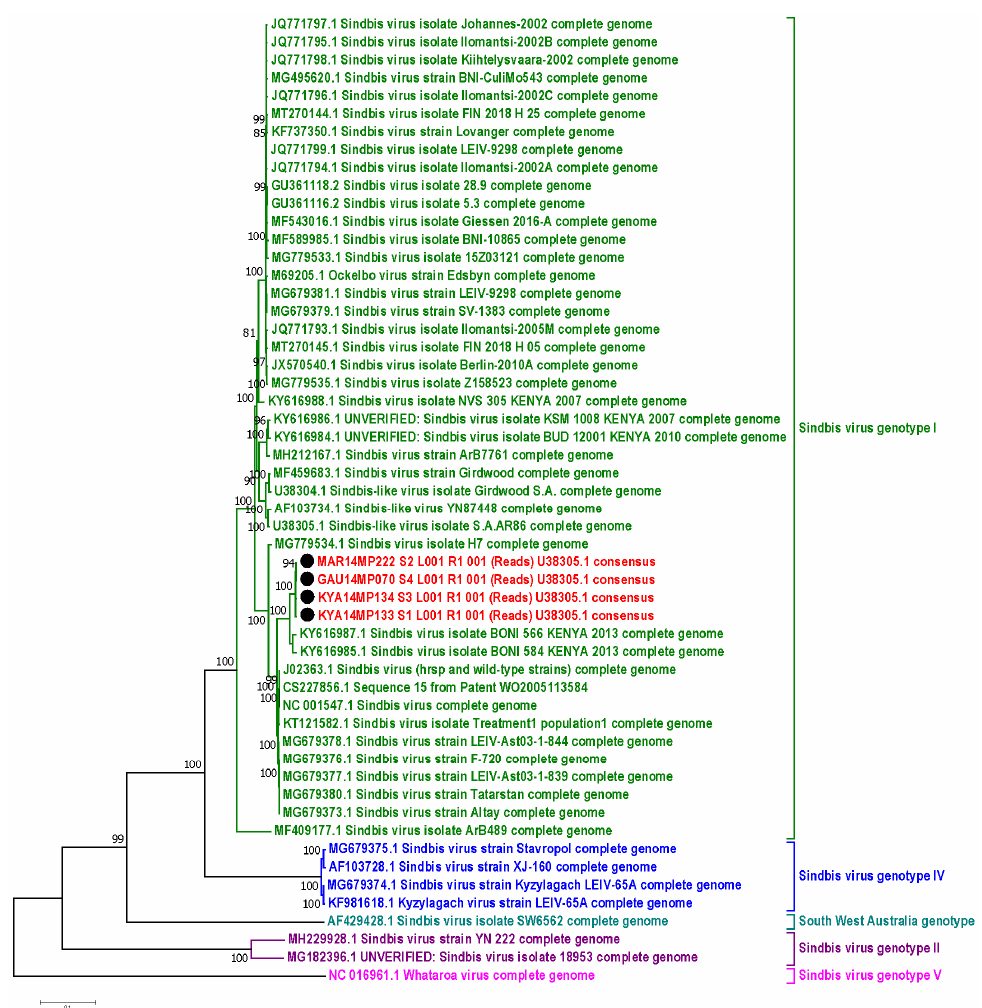
Figure 5. A maximum likelihood phylogenetic tree of the full genome sequences of Sindbis virus (11 592 bp), including the four new sequences generated from mosquito pools from this study (black circles). The evolutionary history was inferred by using the Maximum Likelihood method based on the General Time Reversible model. The solid black circles represent the four mosquitoes from which the SINV full genome was obtained. Red sequences were identified in this study, and they clustered in genotype I with the sequences labeled green. Genotype II is labeled purple, genotype IV navy blue, genotype V pink, and the South-West Australia which clusters on its own is labeled turquoise blue.